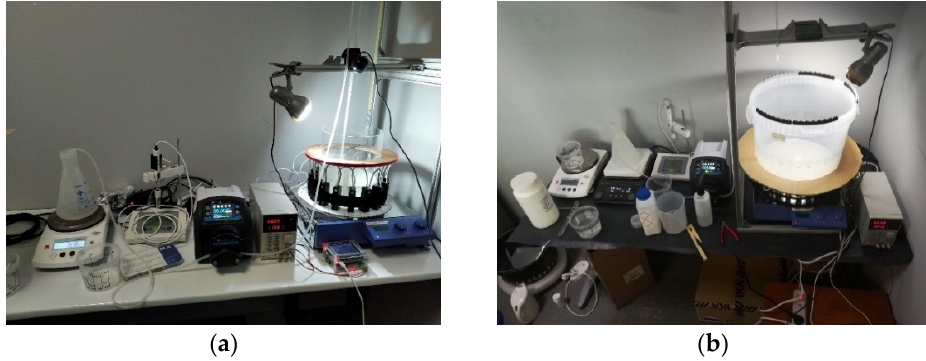
Figure 2. ( a ) USCT ring array integrated to a 20 cm-diameter acrylic tank. ( b ) USCT ring array integrated to a 32 cm-diameter polypropylene tank.